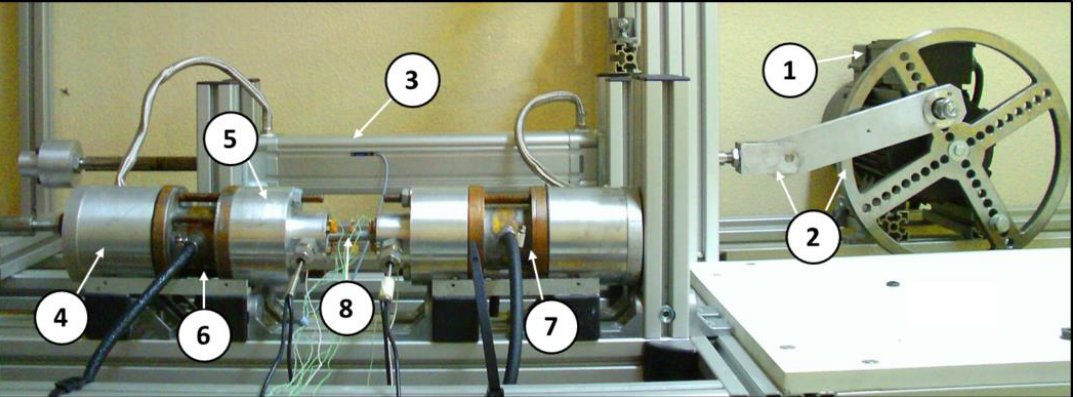
Figure 1. Experimental test bench composed of 1: electrical motor, 2: cylinder and crank shaft, 3: pneumatic cylinder, 4 and 5: connecting tubes, 6: hot heat exchanger (HHEX), 7: cold heat ex- changer (CHEX), and 8: regenerator under test.